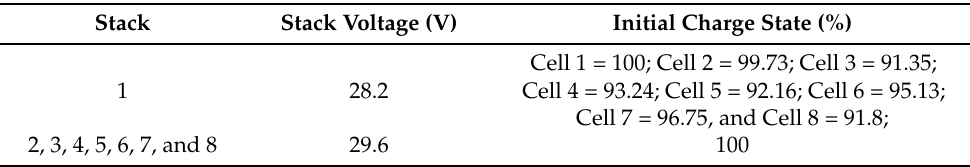
Table 2. Initial charge state values used in battery pack